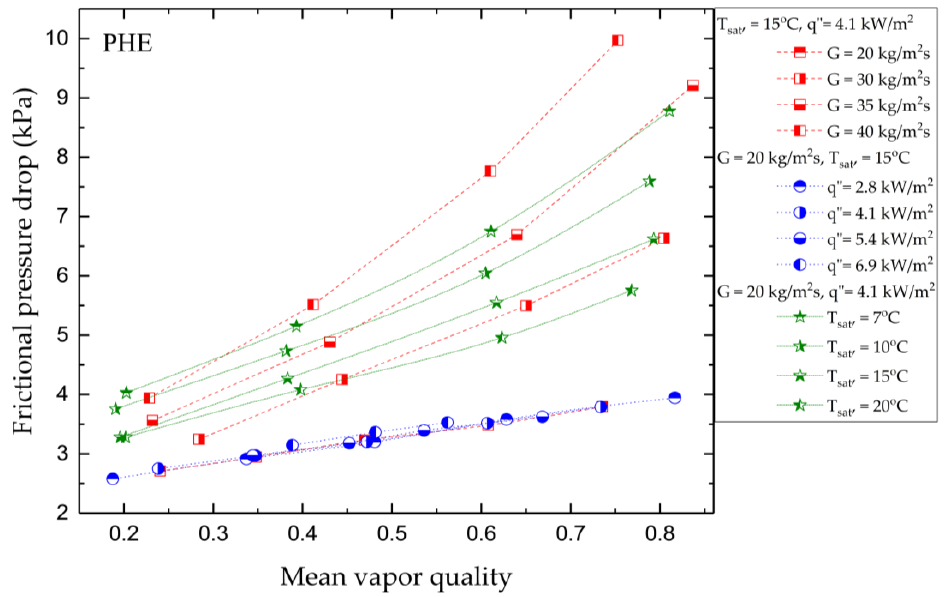
Figure 19. Average evaporation HTC comparison of R-1234ze(E) at variable operating conditions in the SPHE